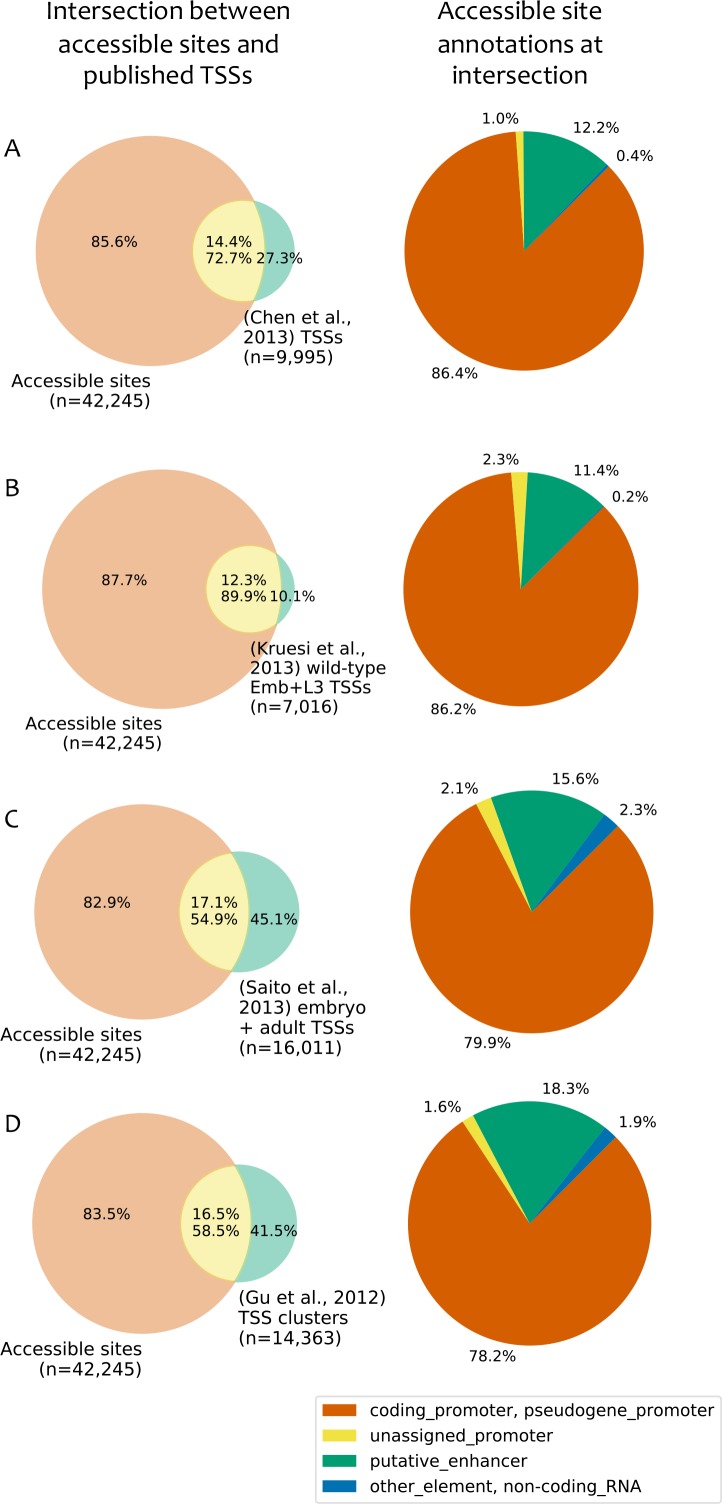
Comparison to published TSS maps.(A–D) Left: overlap between accessible sites and TSS annotations from (A) (Chen et al., 2013); (B) (Kruesi et al., 2013); (C) (Saito et al., 2013); (D) (Gu et al., 2012). Right: accessible site annotations of elements that overlap a TSS in the indicated study. TSSs were considered to overlap an accessible site if they were located within 150 bp of peak accessibility. For Gu et al. (2012), TSSs were clustered using a single-linkage approach using a distance threshold of 50 bp, and the overlaps are based on those clusters.